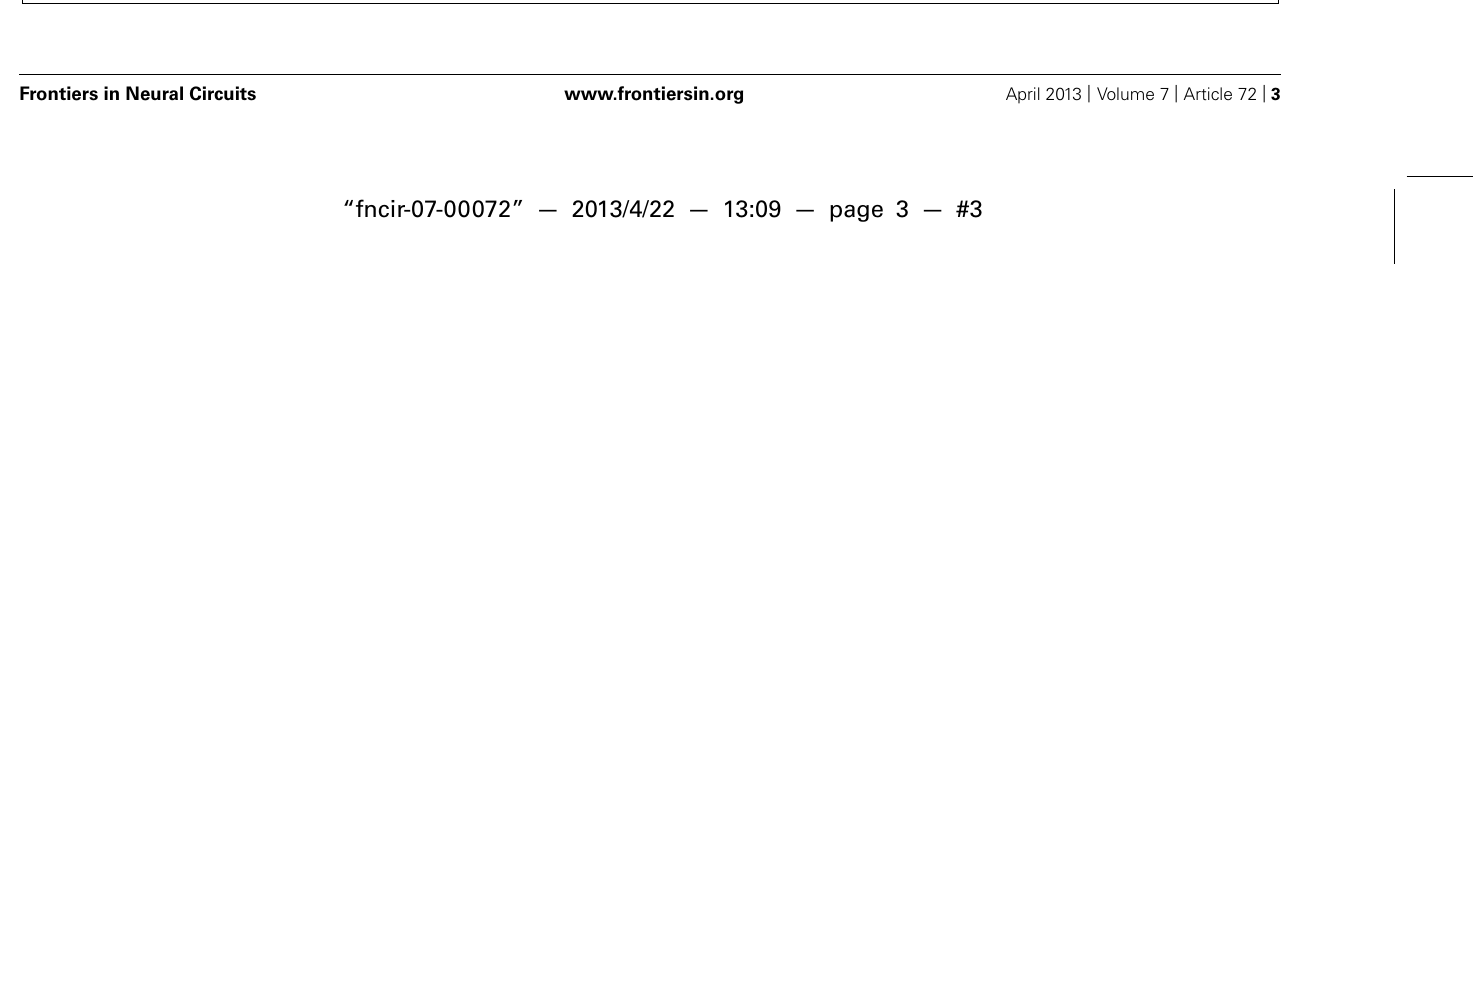
FIGURE 1 | PAG-olivo-cerebellar connectivity. (A) Microinjection of viral anterograde tracer (AAV-CMV-eGFP) into the vlPAG (left panel, injection site indicated by arrowhead; scale bar, 0.5 mm) leads to terminal labeling in the medial accessory olive (middle panel, indicated by arrowheads; scale bar, 100 μ m) and dorsal accessory olive (right panel, indicated by arrowheads; scale bar, 30 μ m) and also principal olive (not shown). (B) Left, posterior view of the rat cerebellum illustrating the distribution of responses evoked by stimulation of left dlPAG at intensity of 2x threshold in one experiment under sodium pentobarbital anasthesia (60 mg/kg administered intraperitoneally).